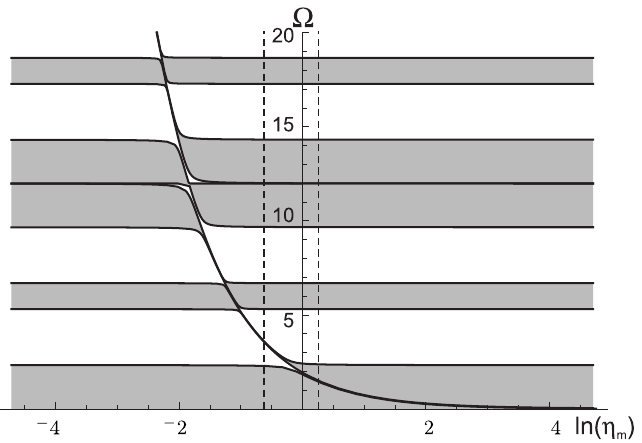
Figure 7. Oscillator in parallel. Band distribution as a function of the characteristic frequency ratio η m . Normalised frequency Ω is given for ξ c = 0.22, η c = 0.5 and ξ m = 8.71. Dashed lines indicate the